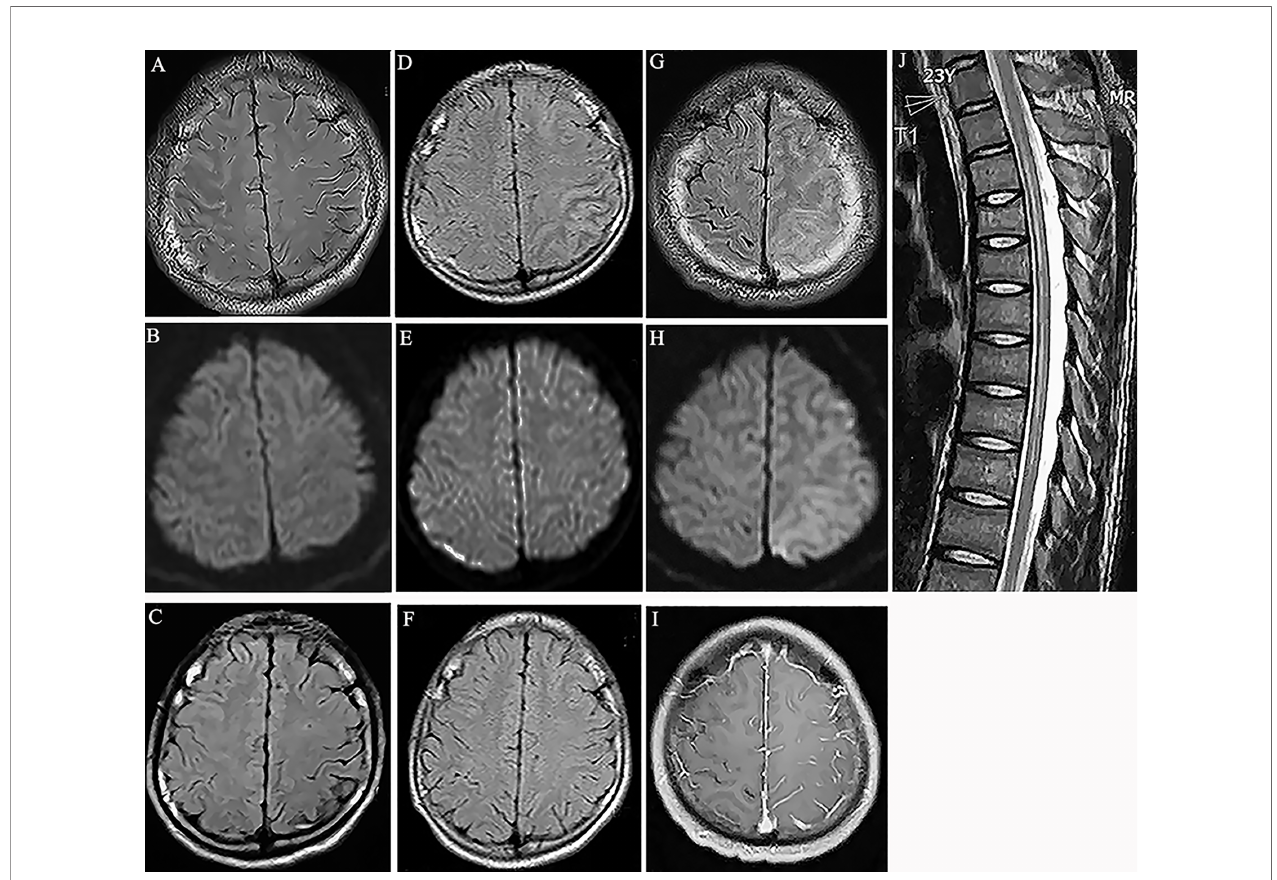
FIGURE 1 | (A) Fluid attenuation inversion recovery (FLAIR) image showed hyperintensity in the cortical region of right frontal and parietal lobes without white matter involvement (Case 1). (B) Diffusion weighted imaging (DWI) showed no obvious signal change in the cortex (Case 1). (C) MRI scan showed the abnormality disappeared at the follow-up scan (Case 1). (D) Hyperintensity in the cortical regions of left parietal lobes in MRI FLAIR images 7 years before this episode (Case 1). (E) DWI showed no obvious signal change in the cortex (Case 1). (F) MRI scan showed the abnormal lesions disappeared at the follow-up scan (Case 1). (G) Hyperintensity in the cortical regions of left frontal and parietal lobes in MRI FLAIR images (Case 2). (H) DWI showed mild hyperintensity in the involved cortical regions (Case 2). (I) Gadolinium enhanced T1-weighted image showed meningeal linear enhancements in the sulci of left brain lobes (Case 2). (J) T2-weighted image showed hyperintensity in the spinal cord from thorax 2 to 9 segments. (Case